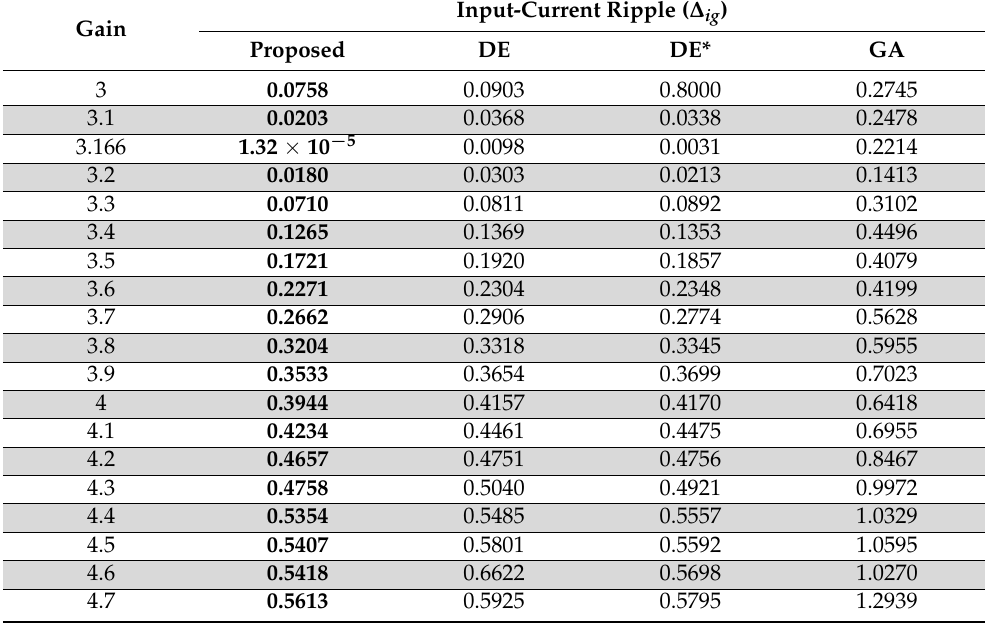
Table 3. Comparison of proposed method with DE and GA algorithms. Gain